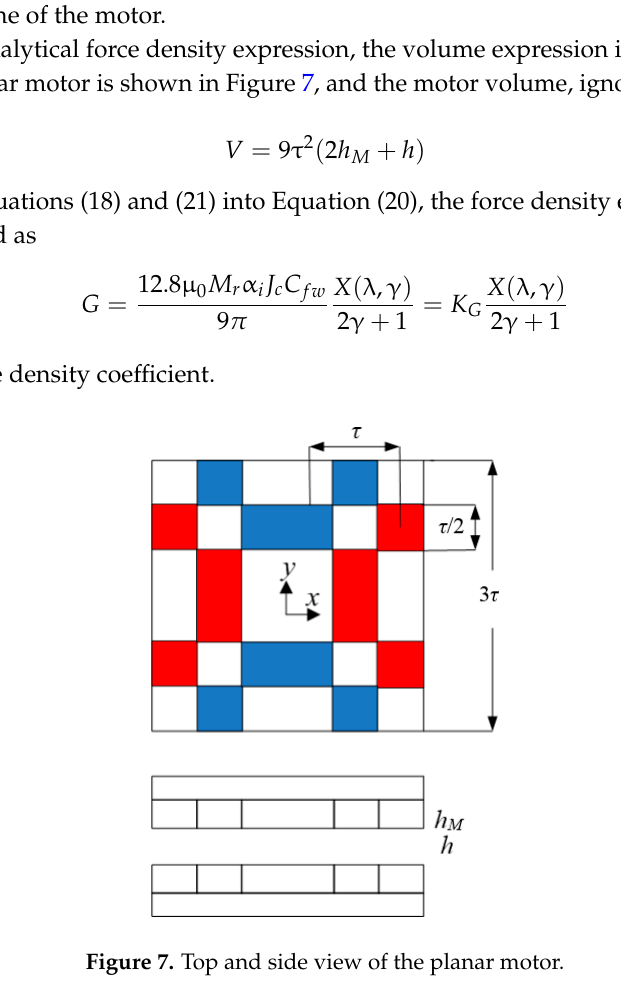
8 of 15 Figure 6. Force characteristic versus parameter γ : ( a ) with different H when τ = 50 mm; ( b ) with different τ when H = 20 mm.